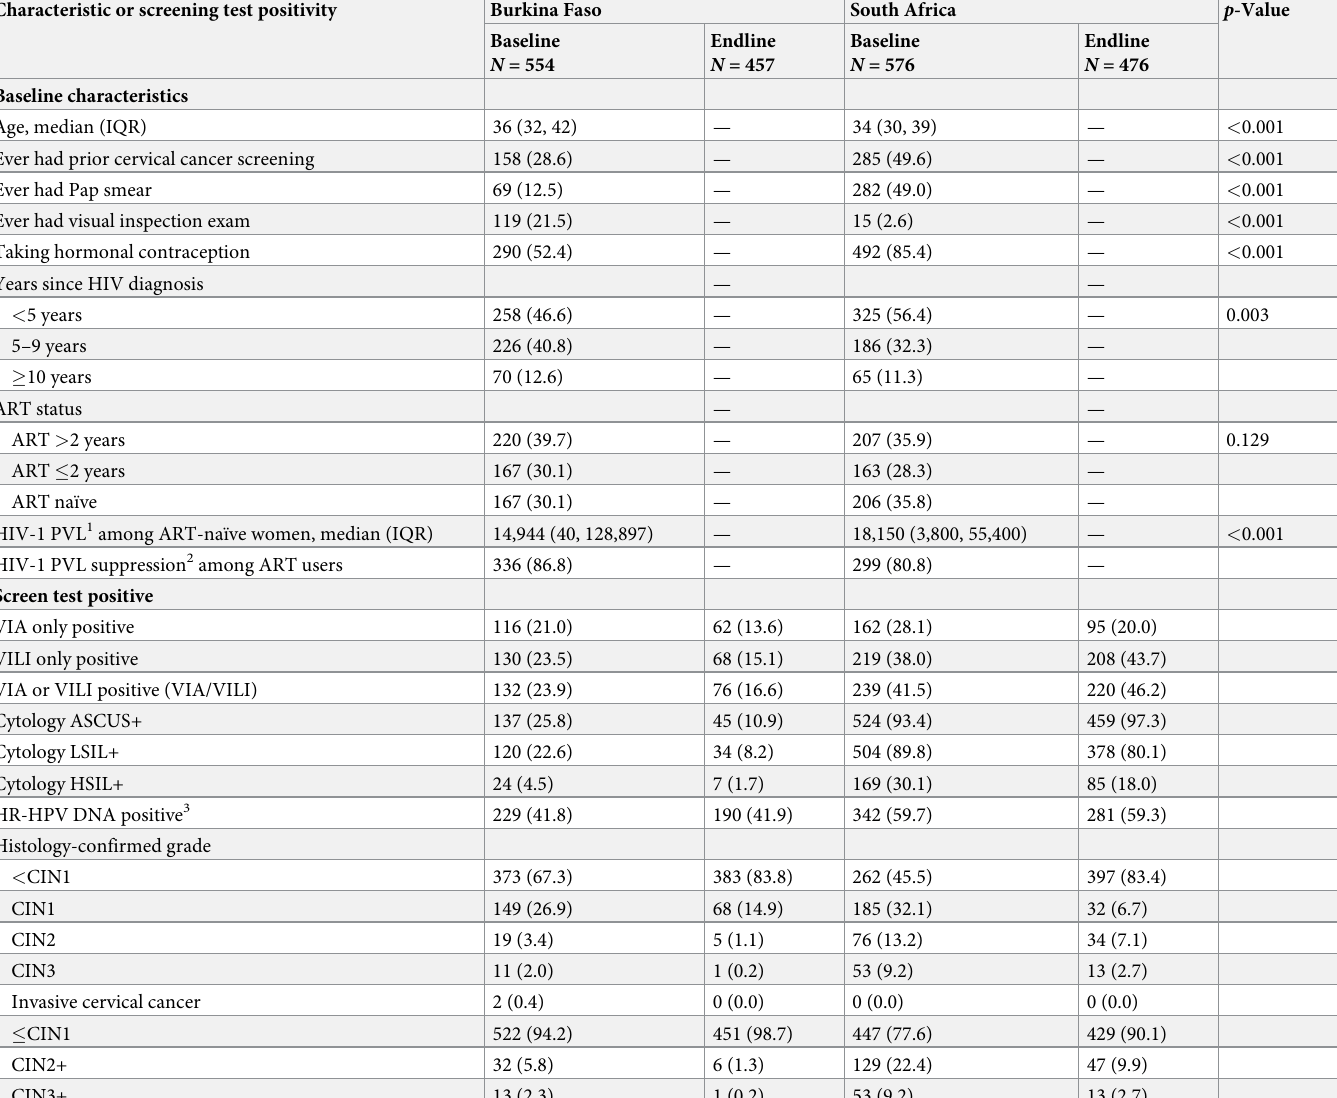
Table 1. Patient characteristics and screening test positivity at baseline and endline in Burkina Faso and South Africa. Characteristic or screening test